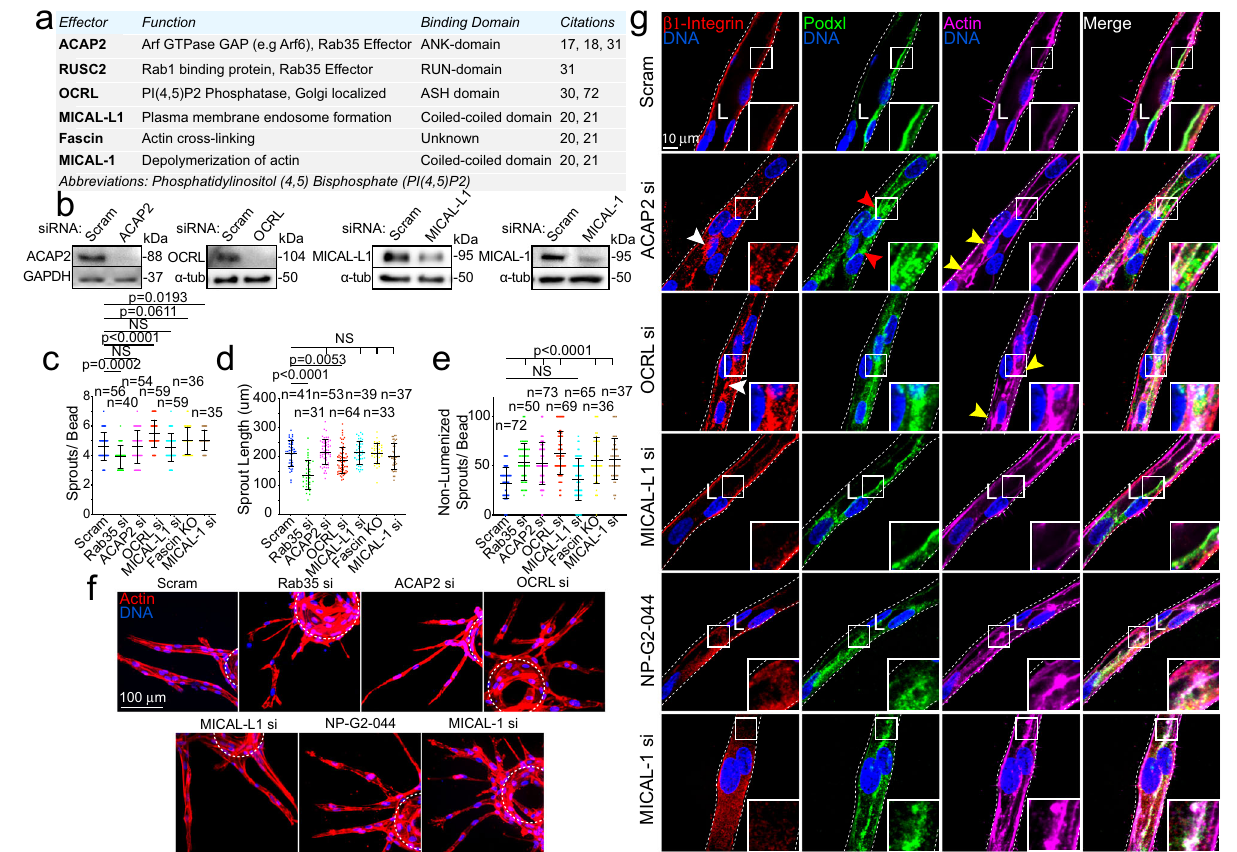
Fig.3|Rab35effectorlocalizationandrequirementforsprouting.a Tablelisting each effector, respective function, and citations. b ACAP2, OCRL, MICAL-L1 and MICAL-1 knockdown(KD)validationby westernblotting(ACAP2average 70.5%KD relativetocontrol, n =3;OCRLaverage72.9%KDrelativetocontrol, n =3;MICAL-L1 average 61.5% KD relative to control, n =3; MICAL-1 average 69.3% KD relative to control, n =4). c – e Graphs of indicated sprout parameters between groups. n=numberof sprouts. Error bars represent standard deviation, middle bars are the mean. f Representativeimagesof sproutmorphologybetweenindicatedsiRNA(si) KD groups. Dashed lines outline microbeads. g Representative images of siRNA-